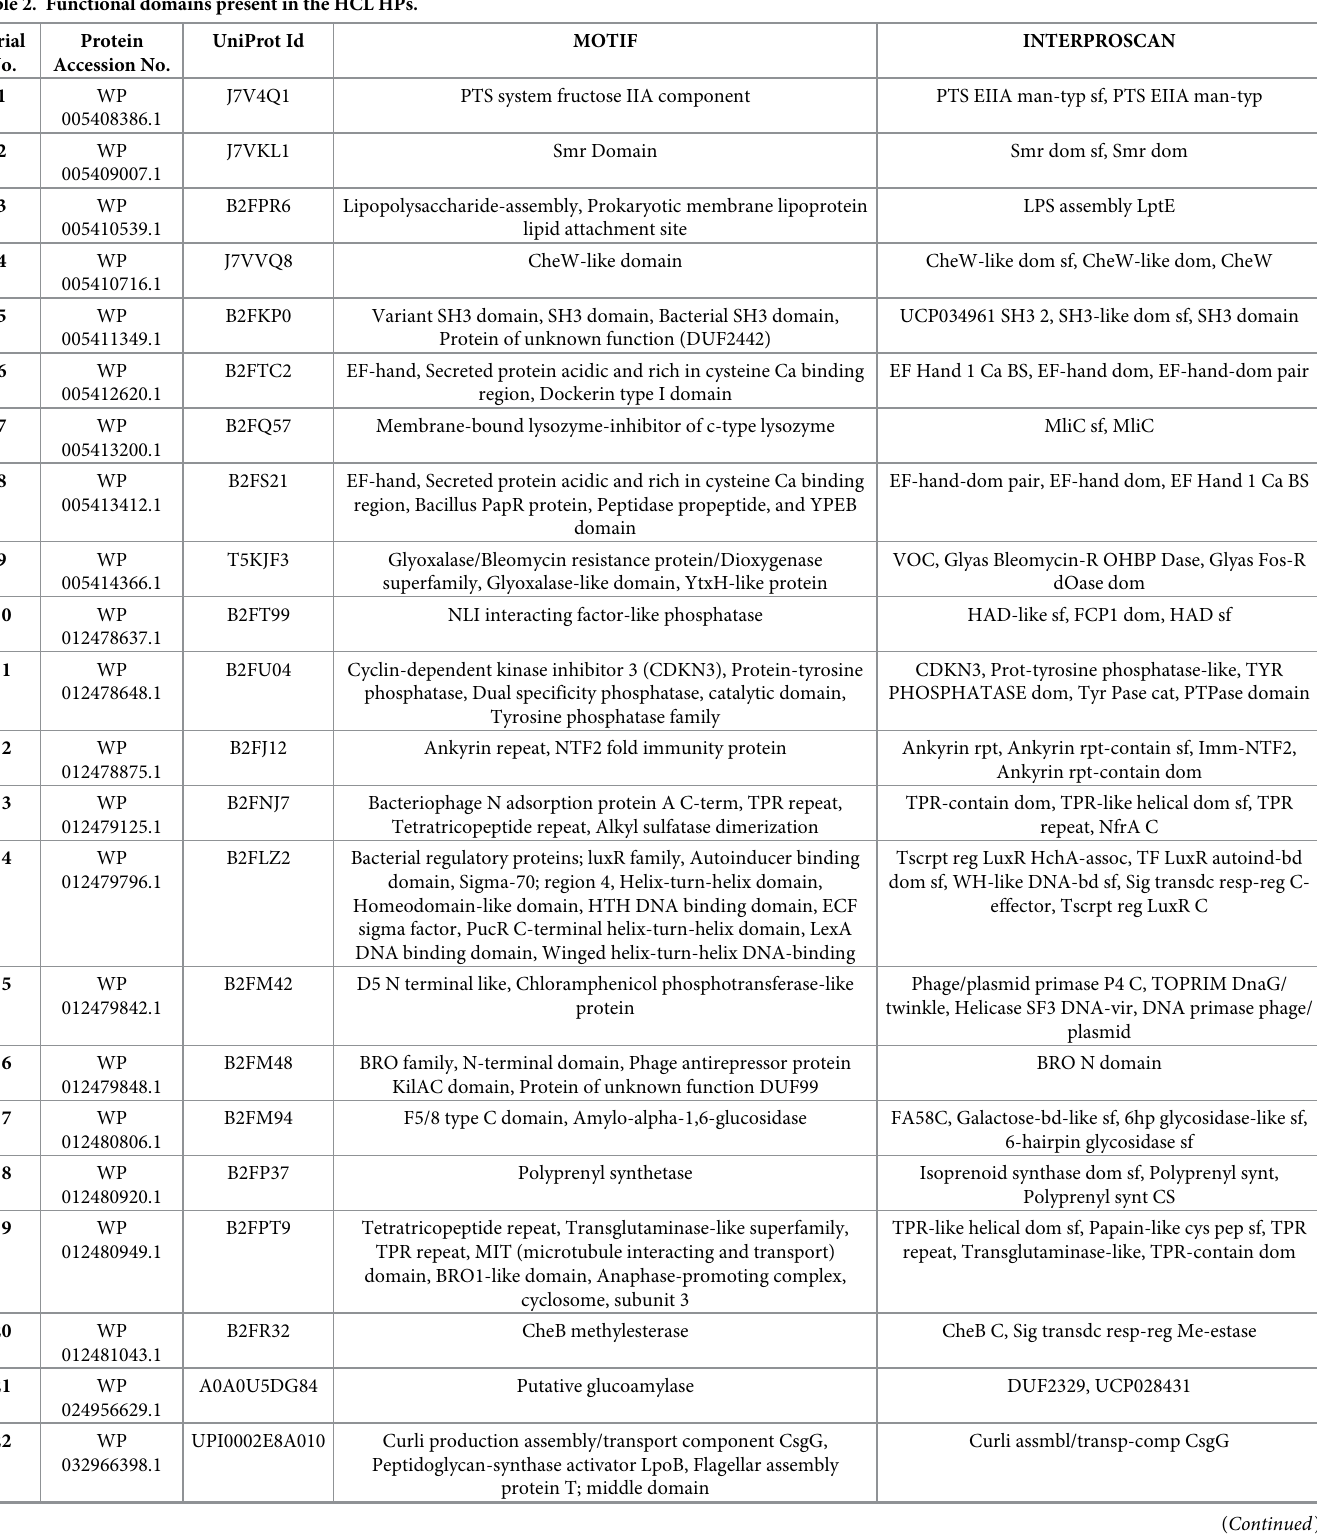
Table 2. Functional domains present in the HCL HPs. Serial